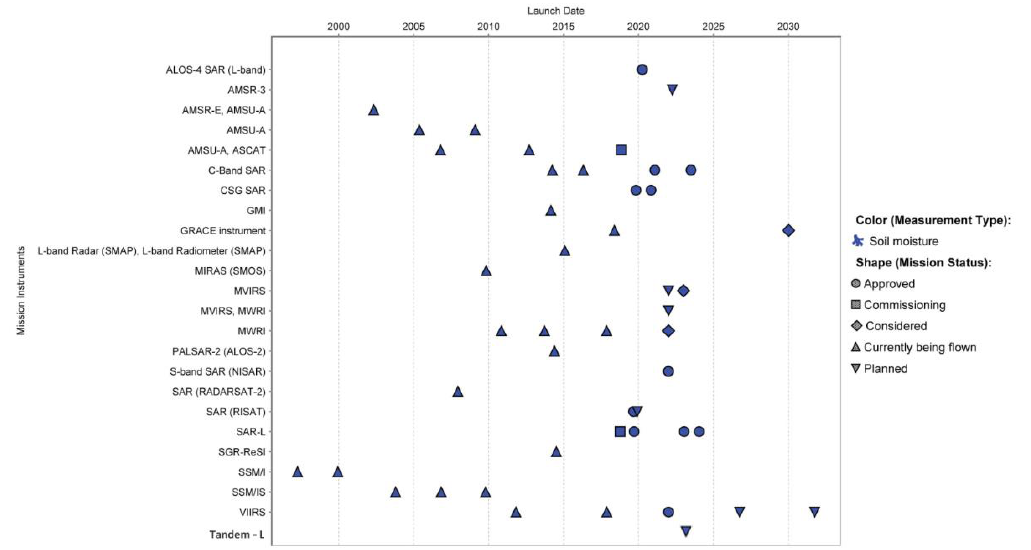
* SMAP RADAR stopped operation on 7 July 2015. Sensor is used on the RS platform: UAV 1 - unmanned aerial vehicles (UAV) ; airborne 2 – airborne RS platform ; spaceborne 3 – spaceborne RS platform.